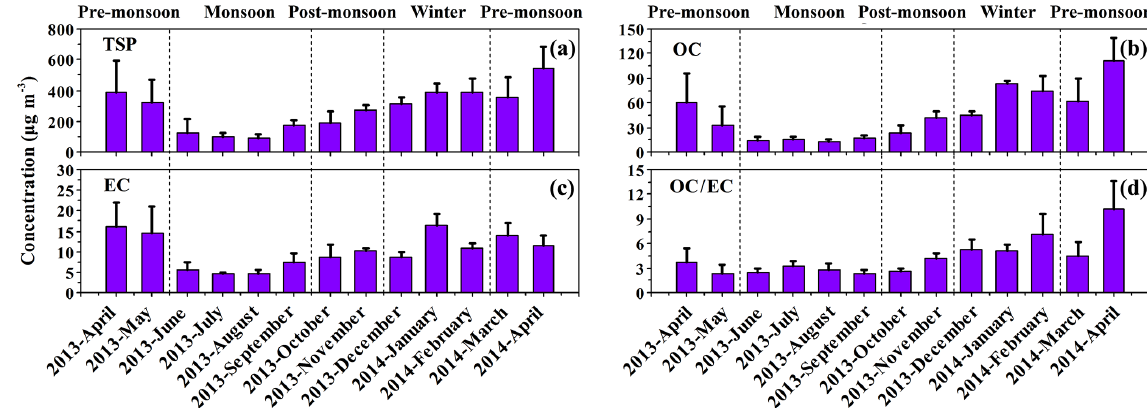
Figure 2. Monthly variations in TSP, OC, EC, and OC / EC ratios at the Bode site, Kathmandu Valley, during April 2013–April